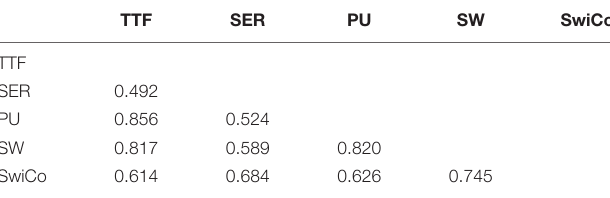
TABLE 3 | Analysis of